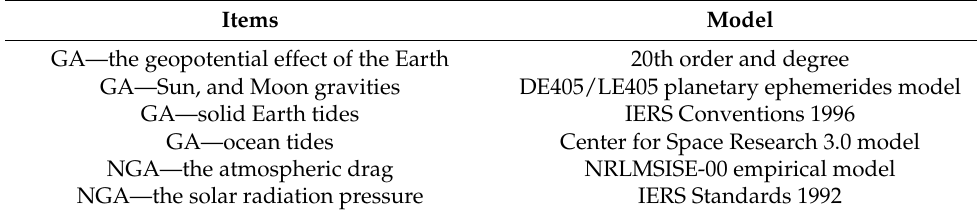
Table 3. Accelerations of gravitational and non-gravitational models.